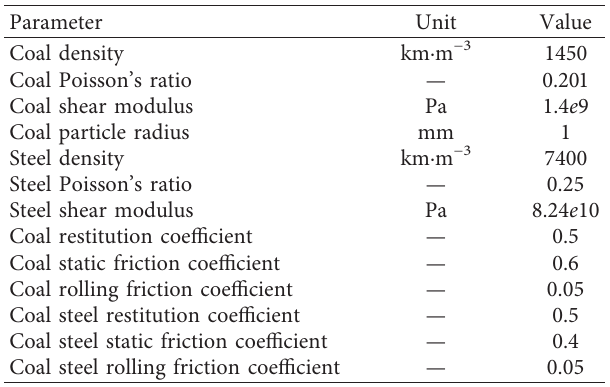
Table 3: Physical parameters of coal and wall.